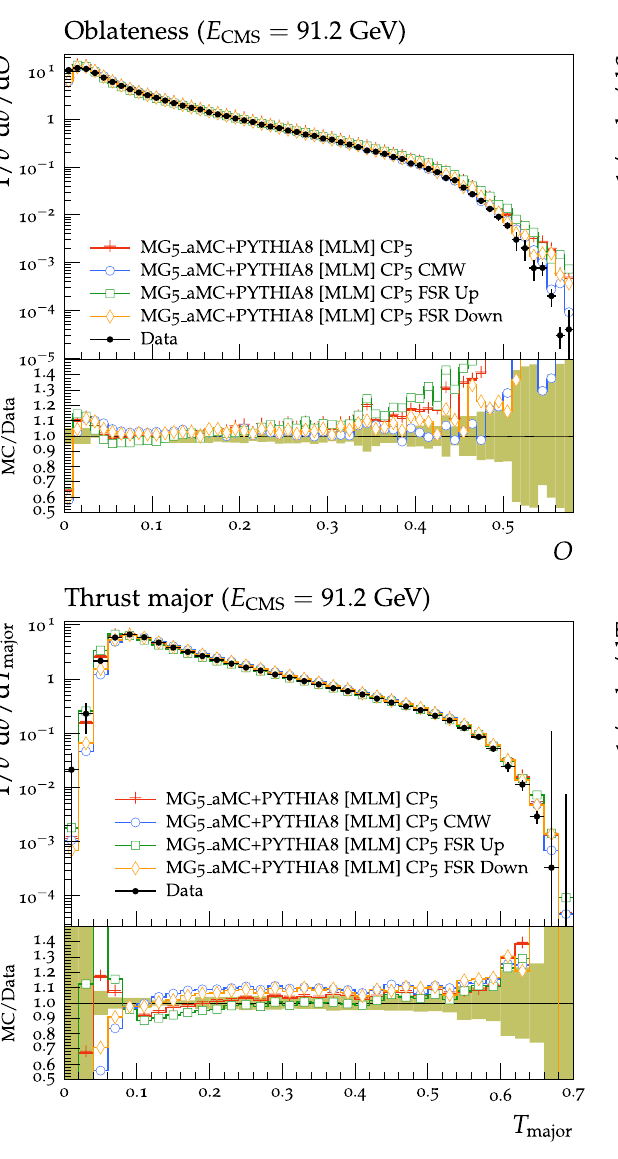
Fig. 12 The normalized cross sections as a function of event-shape (MC/Data) is also shown, where the shaded band indicates the total variables, oblateness (upper left), sphericity (upper right), thrust (lower experimental uncertainty in the data. Vertical lines drawn on the data √ s = 91 . 2GeV left), and thrust major (lower right) from the ALEPH points refer to the total uncertainty in the data. Vertical lines drawn analysis [45], compared with the predictions by mg5 _a mc + pythia 8 on the MC points refer to the statistical uncertainty in the predictions. with k T –MLM merging, for tune CP5, CP5 with CMW rescaling, CP5 Horizontal bars indicate the associated bin FSR up, and CP5 FSR down. The ratio of the simulations to the data